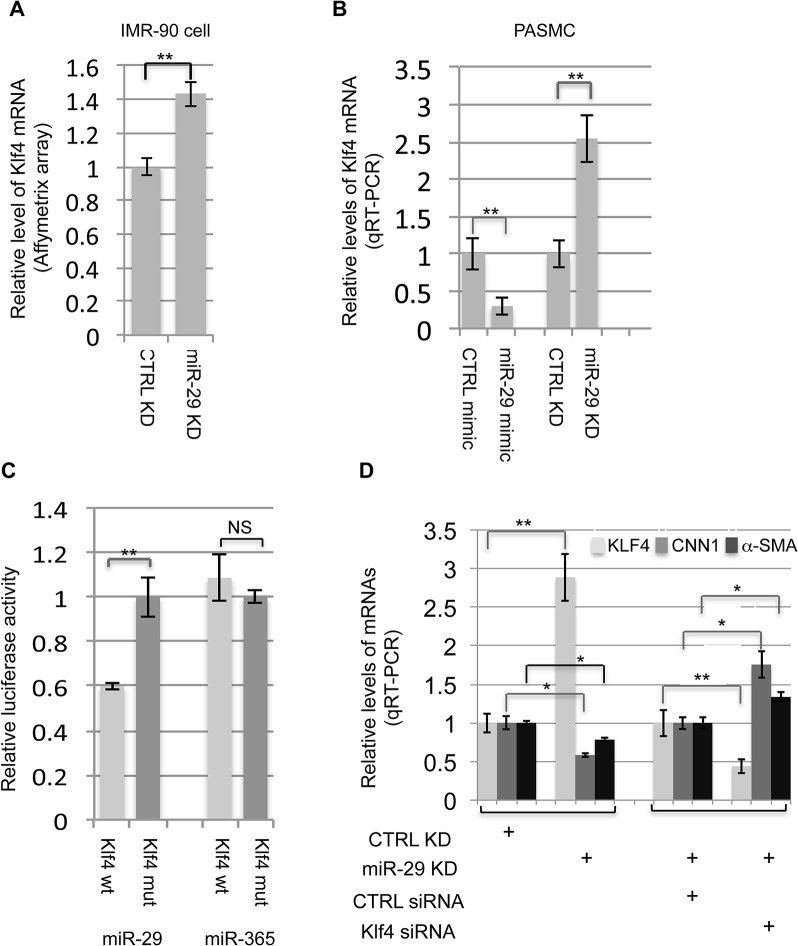
miR-29 regulates KLF4.
(A&B) Knockdown of miR-29 in IMR-90 cells or PASMCs leads to upregulation of KLF4 expression (n = 3); increased miR-29 levels by mimic in PASMCs suppress the expression of KLF4 (n = 3); (C) miR-29 suppresses 3’UTR luciferase reporter of KLF4 which depends on an intact miR-29 binding site (n = 3); (D) Knockdown of KLF4 in PASMCs, in which miR-29 is also knocked down, restore the expression of CNN1 and α-SMA (n = 3). Data are mean ± SEM; Student’s t test, * P<0.05; ** P<0.01.